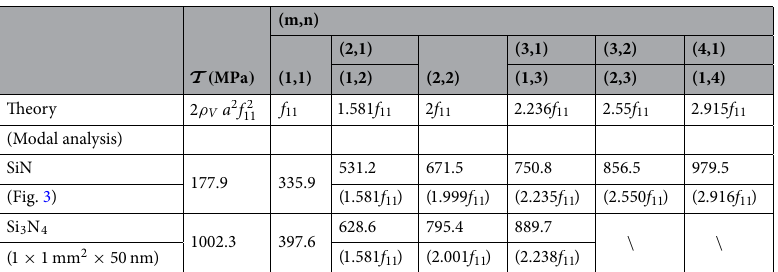
Table 1. Measured resonance frequencies in kHz (for two membranes) with large range mechanical sweep below 1 MHz , and deduced intrinsic in-plane tension. Theoretical values of gap with the fundamental mode are indicated 39 . ρ V is the mass density and a the width of the